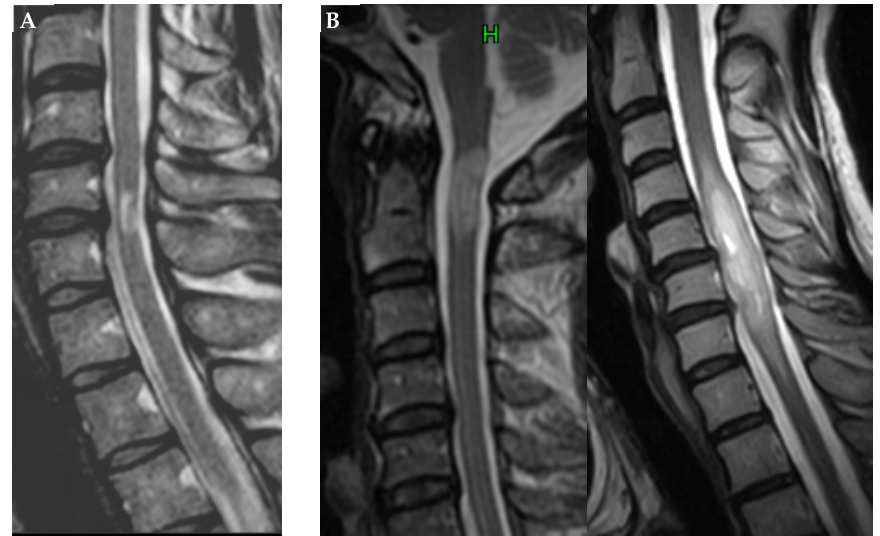
Figure 2. Sagittal T2-weighted MRI showing the absence ( A ) and presence ( B ) of spinal cord enlargement at the intramedullary hyperintensity area.